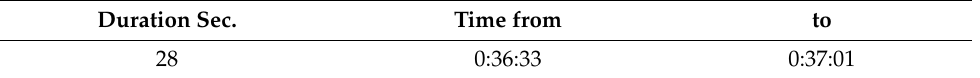
Figure 4. Night sleep of the almost-recovered patient without oxygen supply. Table 3. Falling below the threshold 1 of the oxygen concentration in the blood during night sleep from Figure